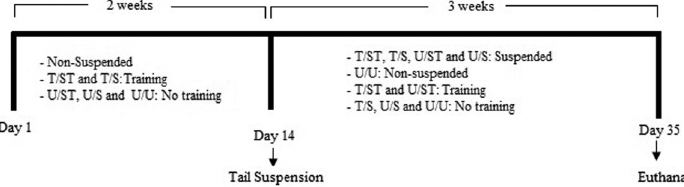
Figure 1. Experimental design. Rats were divided into 5 groups (n=10) as follows: T/ST: jump training before suspension and training during suspension; T/S: jump training before suspension; U/ST: training only during suspen- sion; U/S: suspension without any training, and U/U: untrained and unrestricted in regular